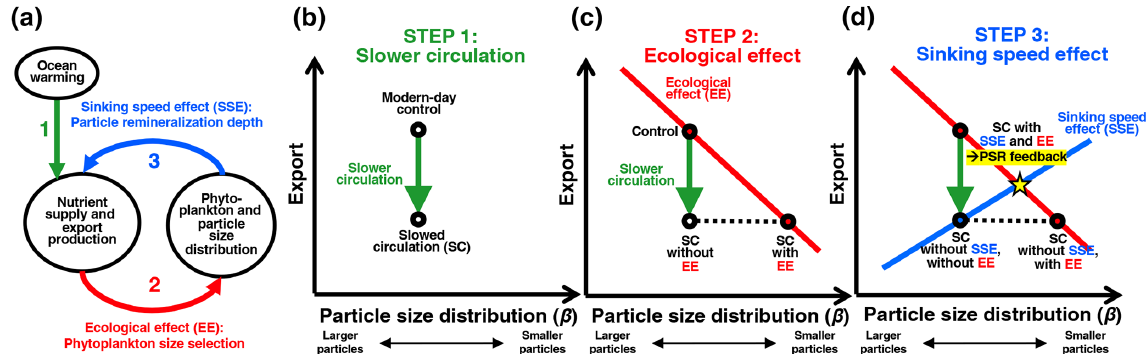
Figure 4. (a) Schematic diagram of the particle-size–remineralization (PSR) negative feedback on export production. A change in circulation rates induced by climate change alters surface nutrient supply and subsequent export production (green arrow). Changes in surface nutrient supply also drive changes in phytoplankton and resultant sinking-particle sizes (red arrow). Changes in sinking-particle sizes in turn alter remineralization depth and consequently surface nutrient supply and export (blue arrow). (b) Schematic depicting decreased export produc- tion with decreases in circulation rates and surface nutrient supply. (c) Schematic depicting a theoretical relationship between export and β , here termed the phytoplankton size selection ecological effect (EE), in which smaller phytoplankton dominate in low-nutrient low-export conditions. (d) Schematic depicting all previous components of the PSR feedback, in addition to the crucial final component: the particle remineralization depth sinking speed effect (SSE), in which smaller particles tend to get remineralized shallower, leading to a greater recycled surface nutrient supply and therefore greater